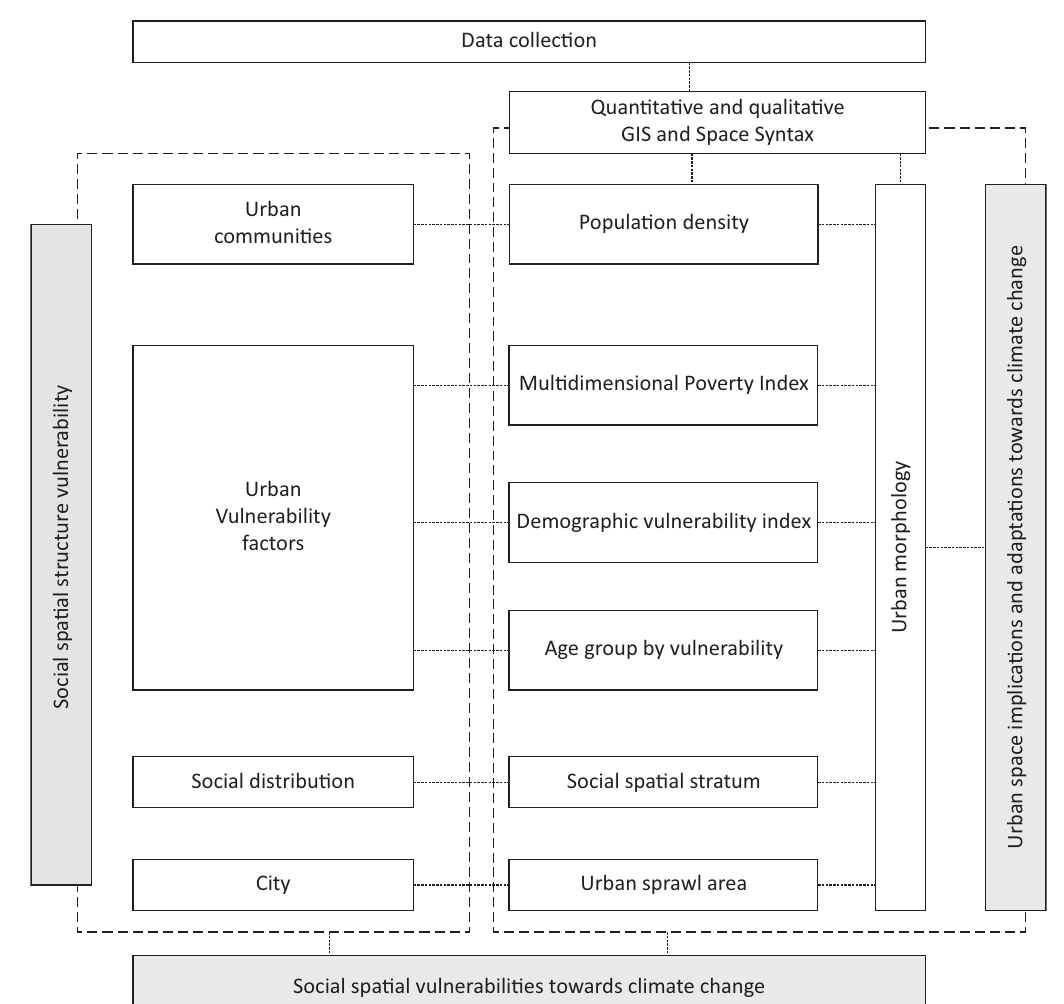
Figure 2. Conceptual framework of social urban spatial structure